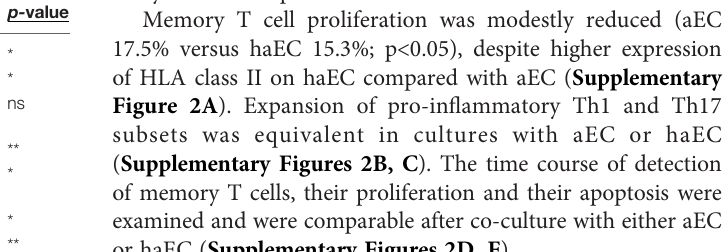
TABLE 1 | Phenotype of endothelial cells activated under different conditions by pro-in fl ammatory cytokines. % cells (mean)